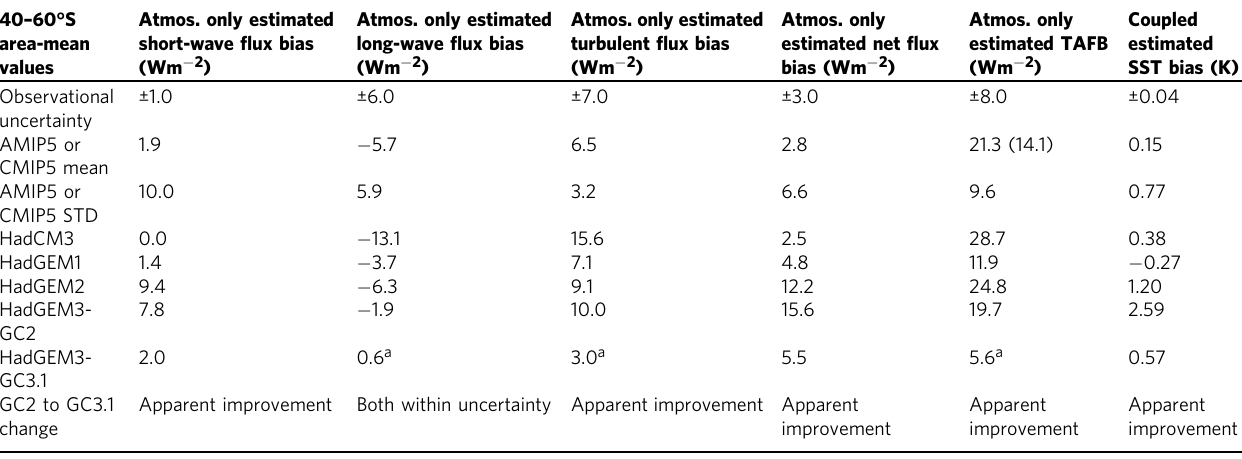
Table 2 Stand-alone atmospheric model surface heat fl ux component biases and Total Absolute Flux Biases and coupled model SST biases averaged over 40 –